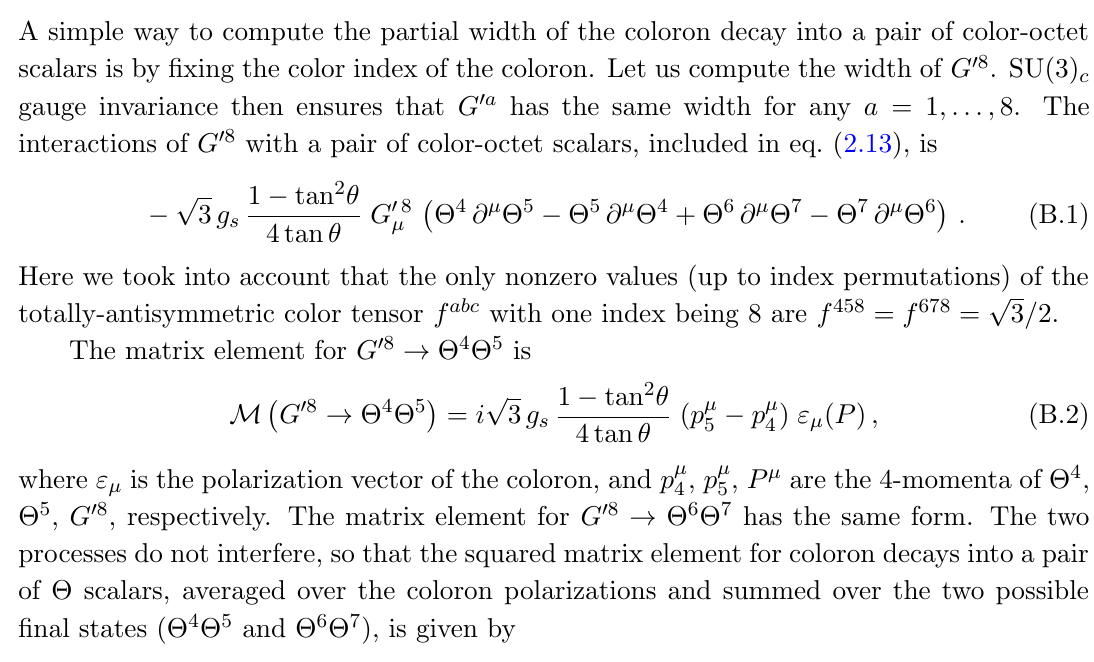
Figure 15 . Allowed range (unshaded region) for the scalar mass ratio M the quartic coupling ratio (cid:20)=(cid:21) . In the pink shaded region the global minimum does not preserve color (for (cid:20)=(cid:21) < 0) or the extended gauge symmetry is unbroken (for (cid:20)=(cid:21) > 0). In the gray shaded region the potential is not bounded from below. The upper limit on M (cid:30) blue line for m 2 > 0 and (cid:20) < 0; the solid red line for m 2 (cid:6) for (cid:20) m 2 > (cid:6)